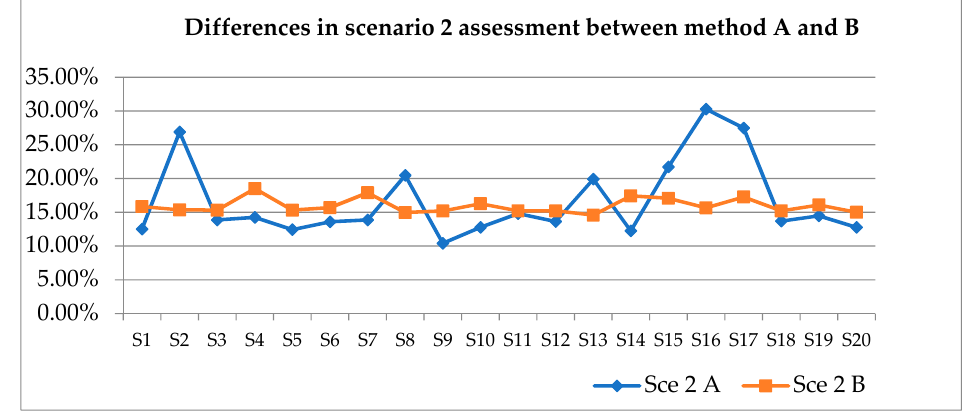
Figure 10. Differences in scenario 2 between multi-actor multi-criteria analysis (method A) and multi-actor multi-criteria analysis with the weight of stakeholder involvement (method B).